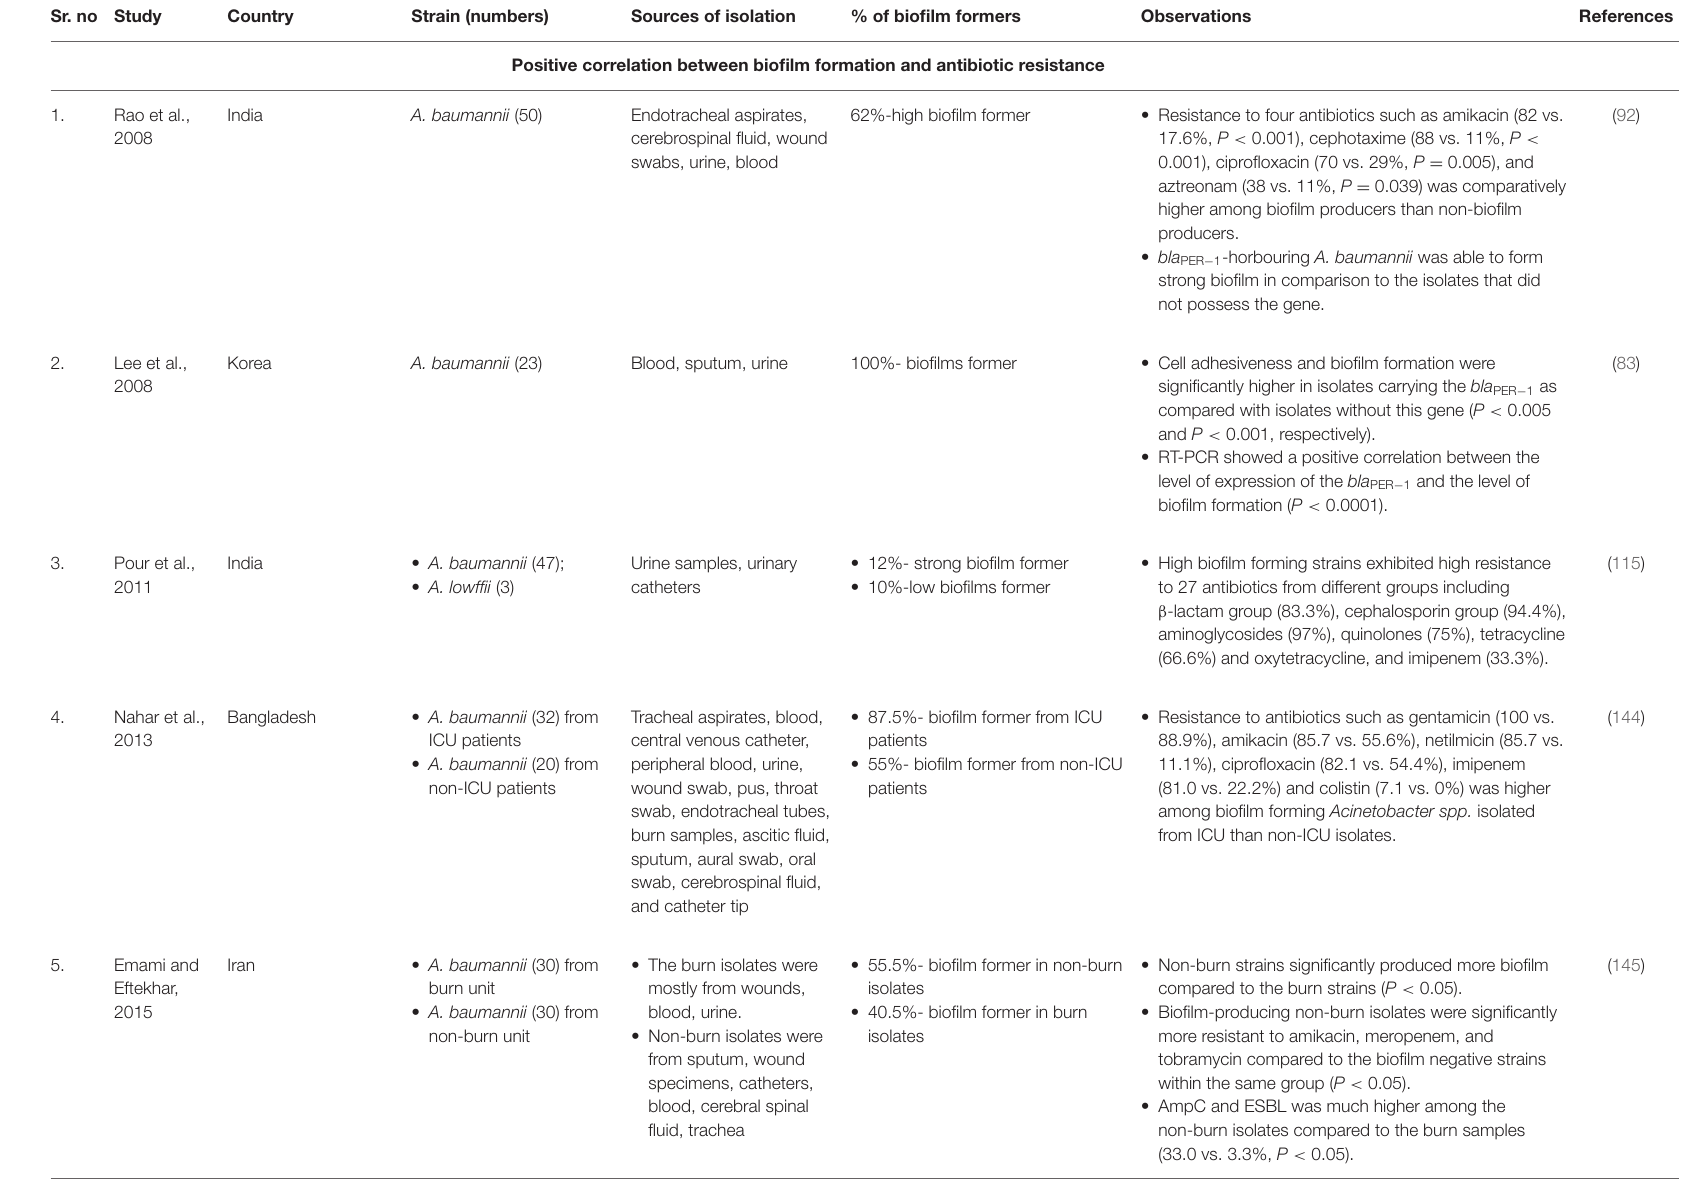
TABLE 2 | Association between biofilm formation and antimicrobial resistance in Acinetobacter spp . Sr. no Study